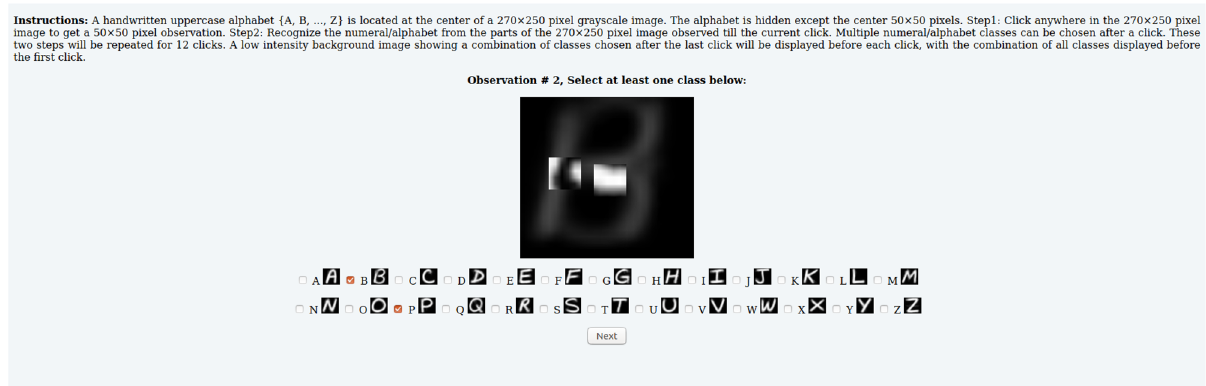
Figure 1. Our MTurk interface as seen by a participant. The second sampling for an EMNIST uppercase alphabet is